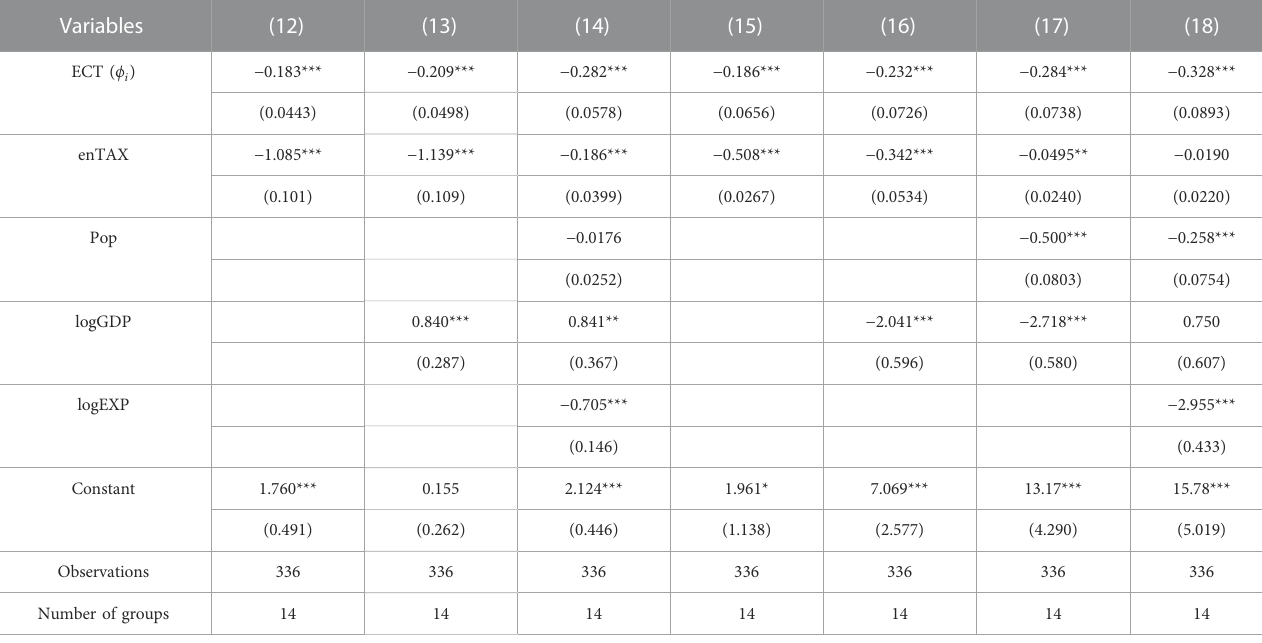
TABLE 5 Pooled mean group PMG — sliced